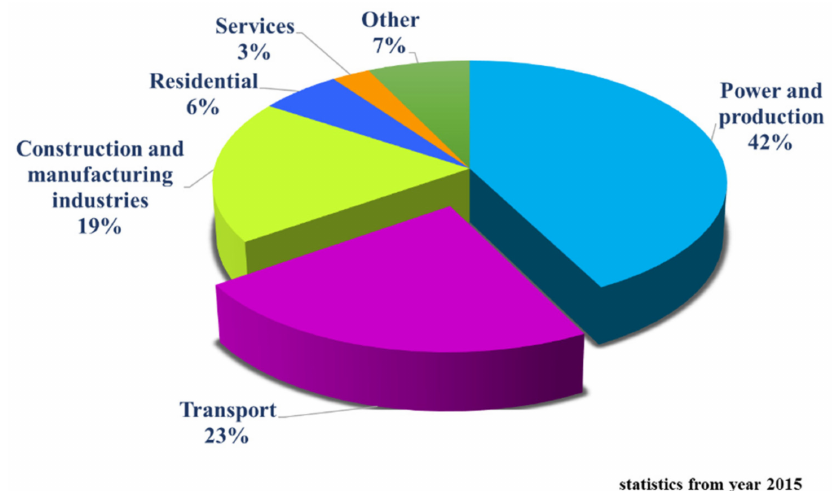
Figure 1. Anthropogenic CO 2 sources and their contribution to the total CO 2 emissions, adapted with permission from